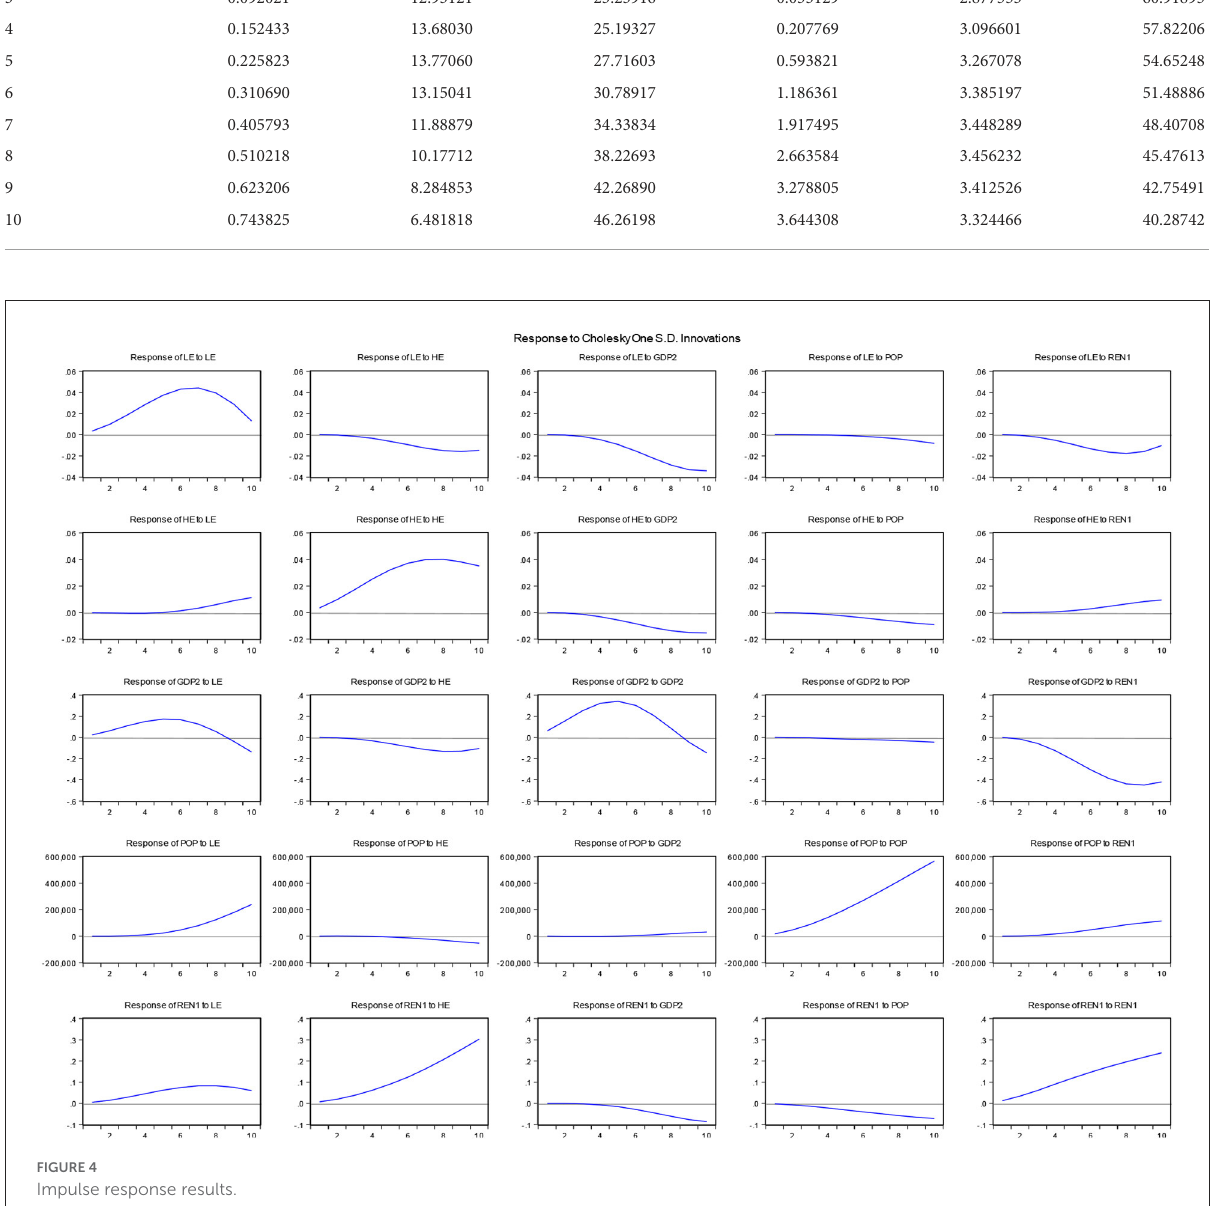
are independent variables. This implies that health